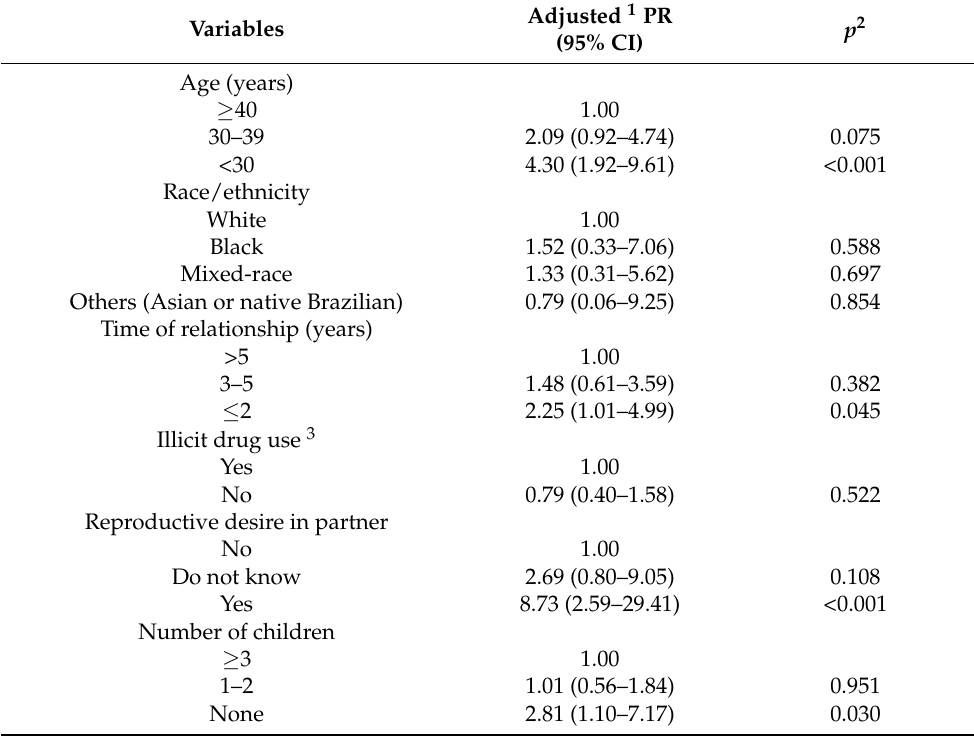
Table 3. Factors associated with reproductive desire in women living with HIV/AIDS with serodis- cordant partners, Goi á s State,